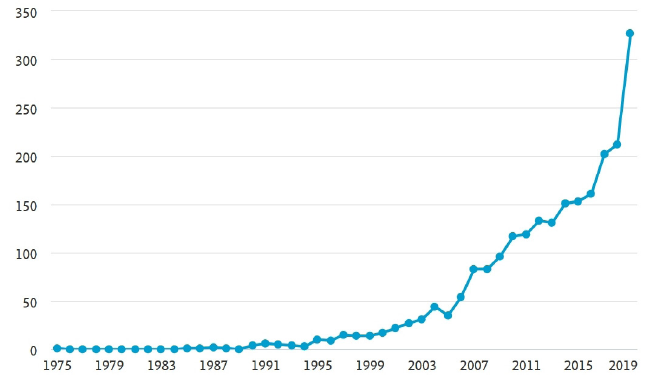
Figure 3. Documents per year (source: Scopus